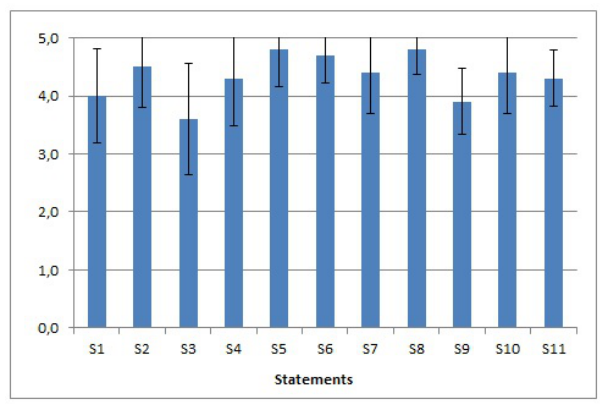
Figure 20. Average responses from